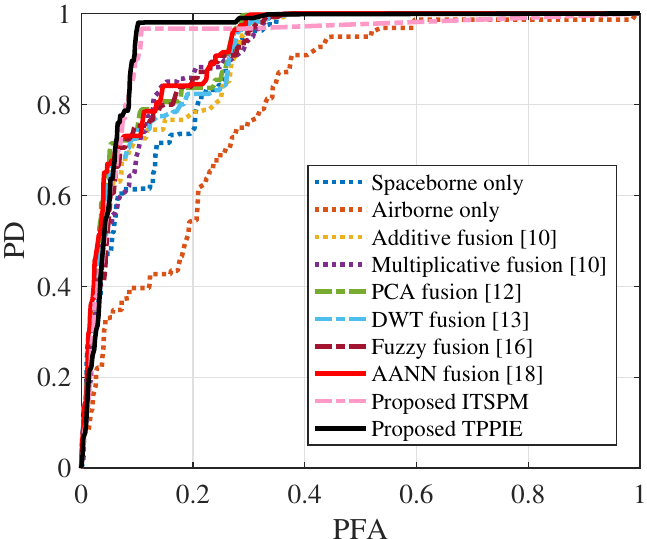
Figure 14. ROC curves of different methods for Experimental Scene 3. When pursuing a relatively high PD (e.g., larger than 0.96), the PFAs of the proposed ITSPM and TPPIE fusion methods were far less than those of the other methods, including spaceborne image processing, airborne image processing, additive fusion [10], multiplicative fusion [10], PCA fusion [12], DWT fusion [13], fuzzy fusion, and AANN fusion